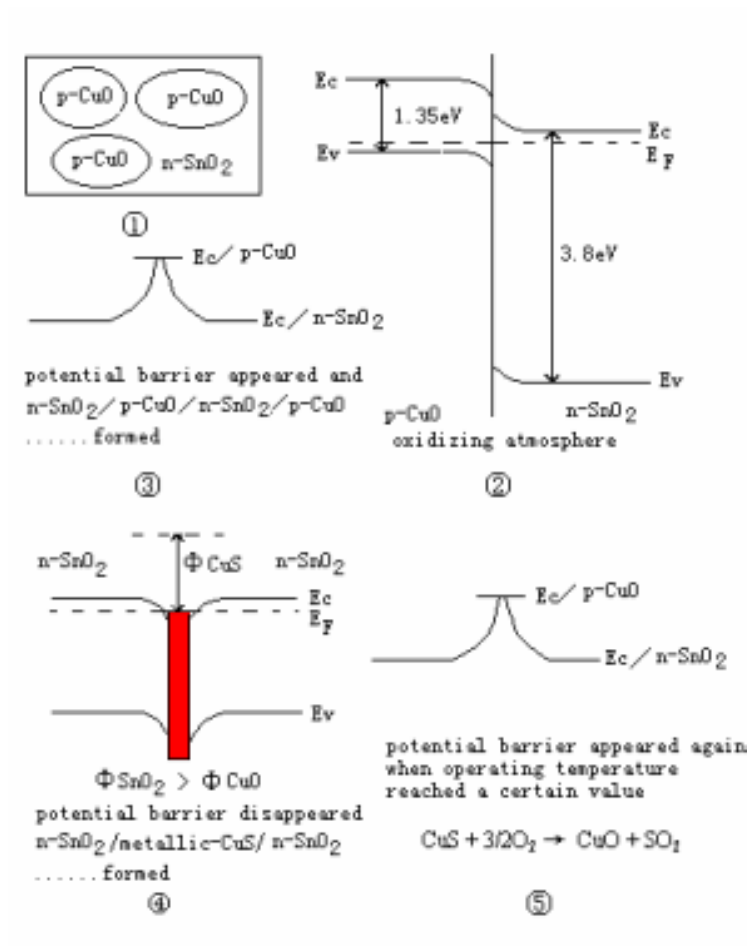
Figure 7. Schematic diagram of CuO/SnO